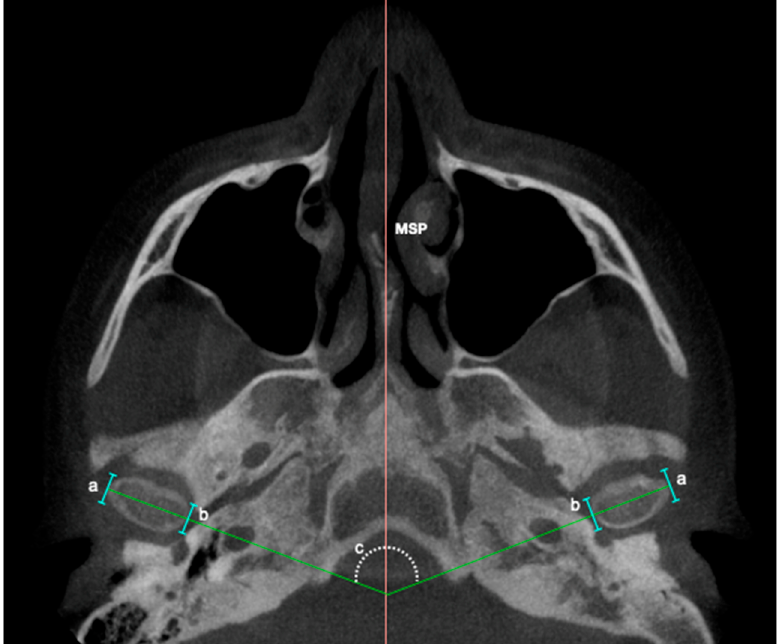
Figure 4. References to obtain the angular measurement of condylar axis with respect to the mid-sagittal plane (MSP). a. Lateral extreme of the mandibular condyle. b. Medial extreme of the mandibular condyle. c. Inner angle between MSP and the line drawn from the projection of higher mid-lateral length of each condyle.